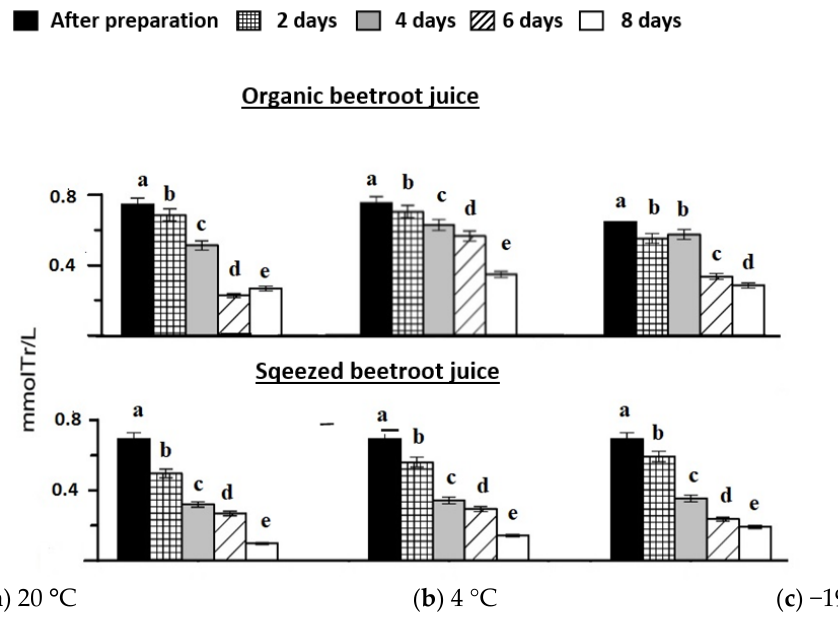
Figure 3. The antioxidant activities of beetroot juices stored at different temperatures, ( a ) 20 °C; ( b ) 4 °C, and ( c ) − 19 °C, using DPPH assay. Different letters indicate a difference at a significance level of p = 0.05. Table 2. The concentrations of the main compounds in the studied beetroot juices during their storage at different temperatures (in mg L − 1